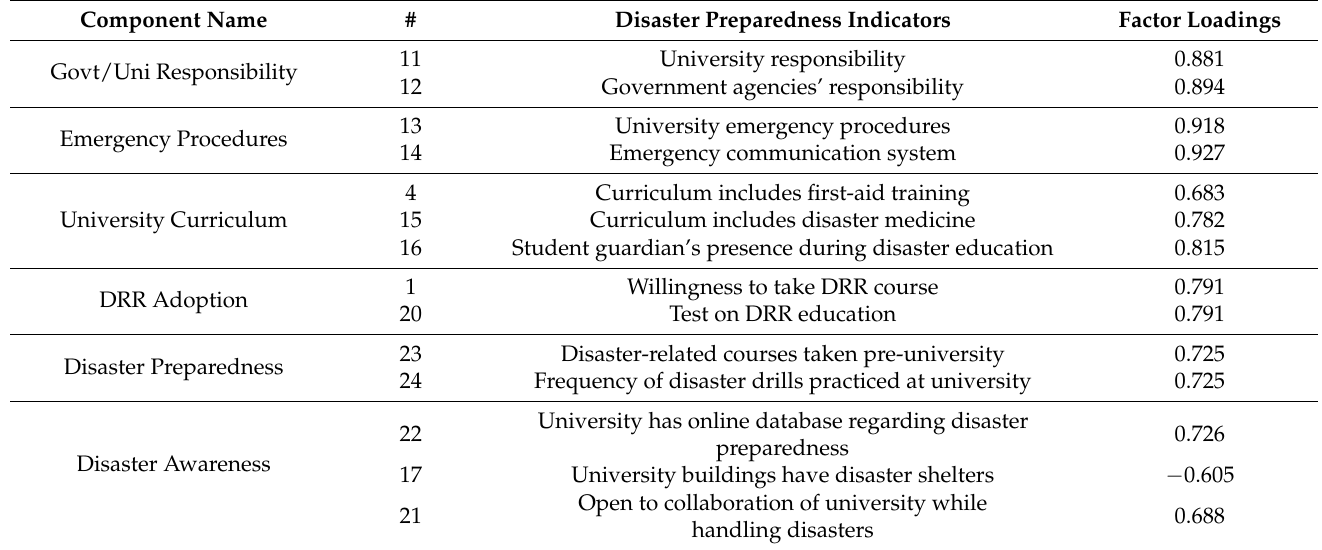
Table 4. Factor Analysis Results.